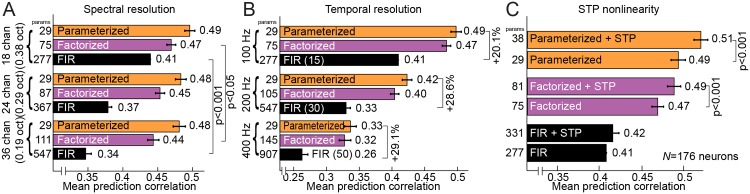
Effects of spectral and temporal resolution on model performance.
A. As the number of cochlear filterbank channels increases from C = 18 to 24 or 36, there is no significant change in performance of the parameterized model. However, performance of the factorized and FIR models is significantly decreased (sign test). B. As temporal resolution is increased from 100 to 200 or 400 Hz, the average prediction correlation of all models decreases. However, FIR model performance degrades more than the factorized and parameterized models. Numbers in parentheses denote the number of temporal bins U used. C. Average performance of models with and without nonlinear short-term plasticity (STP) incorporated into the STRF. STP does not significantly improve performance of the FIR STRF, but it does improve performance of the factorized and parameterized models.